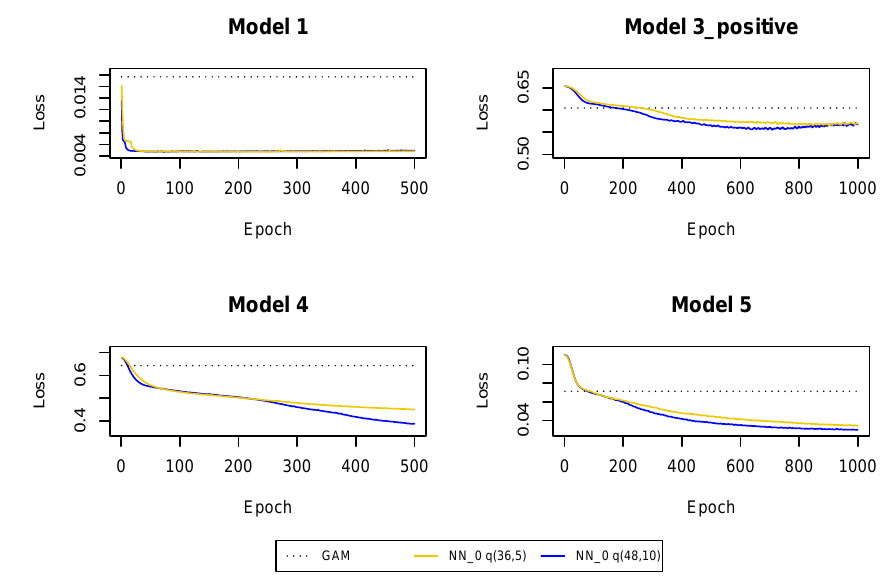
Figure A15. Cross-entropy and deviance loss functions on validation sets observed during the training of the neural networks in k =